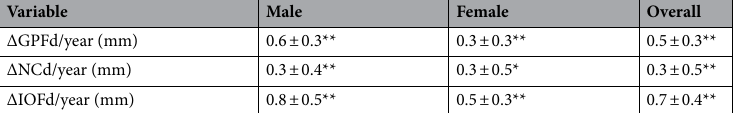
Table 3. Annual changes in linear distances between bilateral skeletal landmarks. Results are mean Values ± standard deviations. * p < 0.001; ** p < 0.0001, indicating statistically significant annual changes. GPFd: Transverse linear distance between greater palatine foramina. NCd: Transverse linear distance between nasal cavity walls. IOFd: Transverse linear distance between infraorbital foramina.